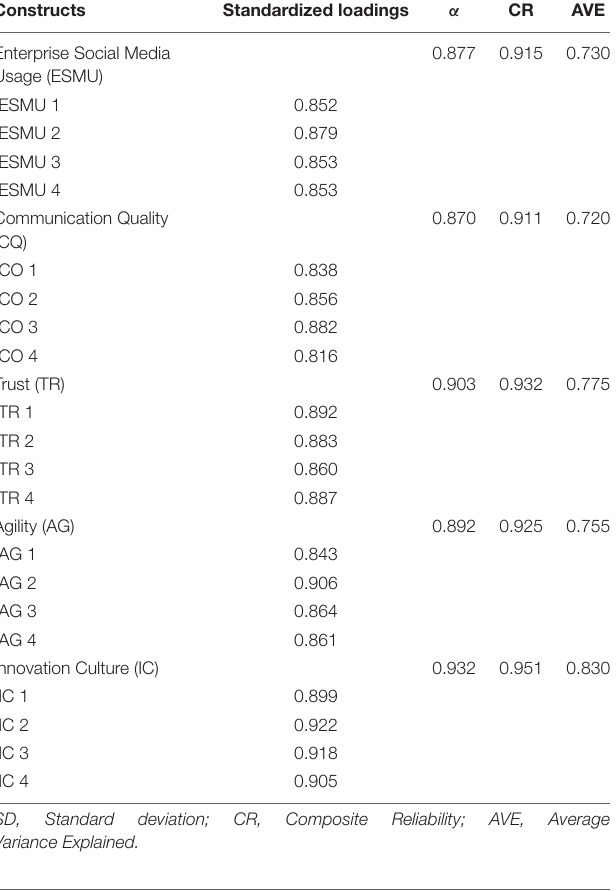
TABLE 3 | Matrix of construct correlation coefficients.